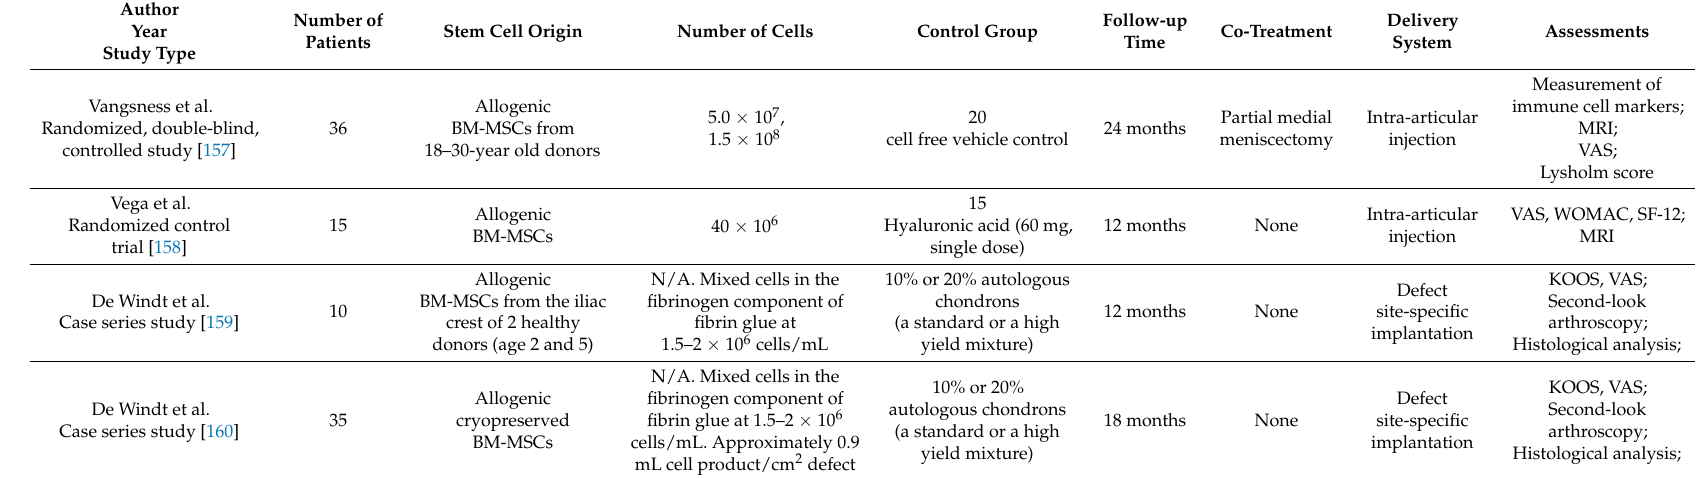
Table 2. List of publications of allogenic mesenchymal stem cells application for cartilage